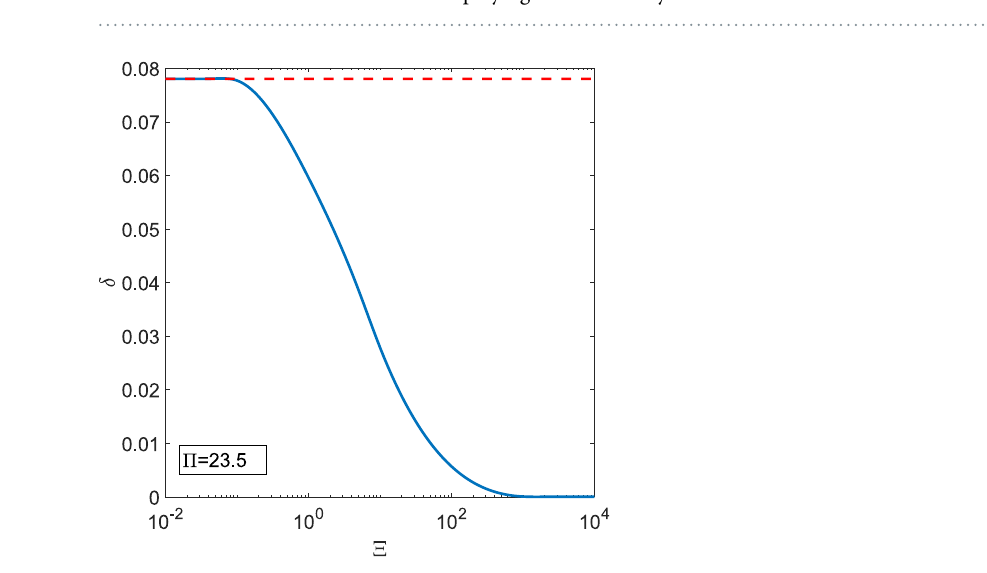
Figure 4. The dimensionless tangential force F t / F n as a function of the dimensionless abscissa for several values of Ξ and Π = 23.5. Blue lines refer to results obtained by means of the viscoelastic reciprocating approach, whereas red dotted lines are obtained employing a classic steady-state model.